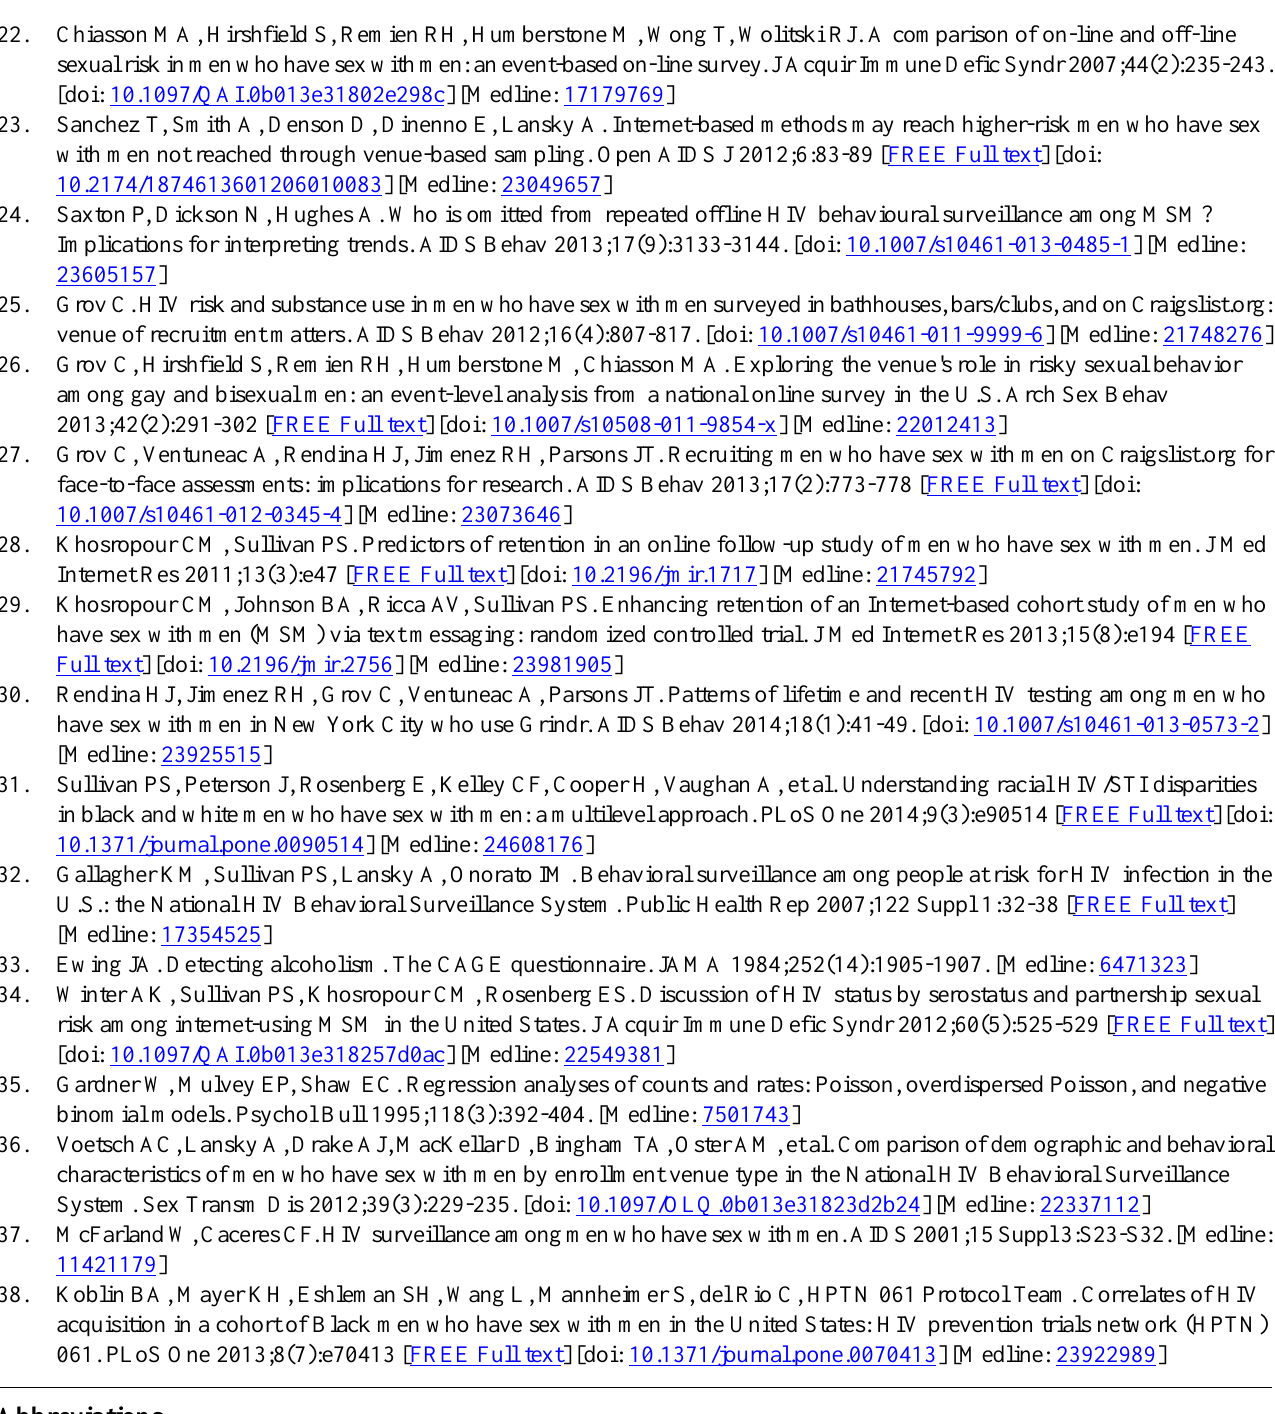
CAGE Scale: CAGE is an acronym of the 4 questions used in the scale (“Cut,” “Annoyed.” “Guilty,” “Eye-opener”) HIV/AIDS: human immunodeficiency virus/acquired immunodeficiency syndrome LR: likelihood